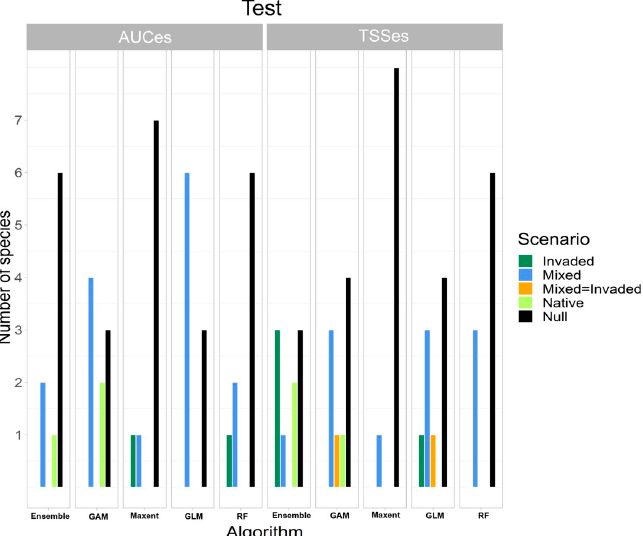
Fig 2. Summary of the best model scenario for the nine invasive species under study according to the three different algorithms/ensemble and the two statistics (i.e. TSS and AUC). ‘Invaded’ scenario included environmental predictors from invaded regions, ‘Native’ included environmental predictors from both native and invaded regions and ‘Mixed’ scenario included environmental and anthropogenic from the invaded region. When two scenario obtained same values another category was created with the ‘ = ‘ symbol to illustrate